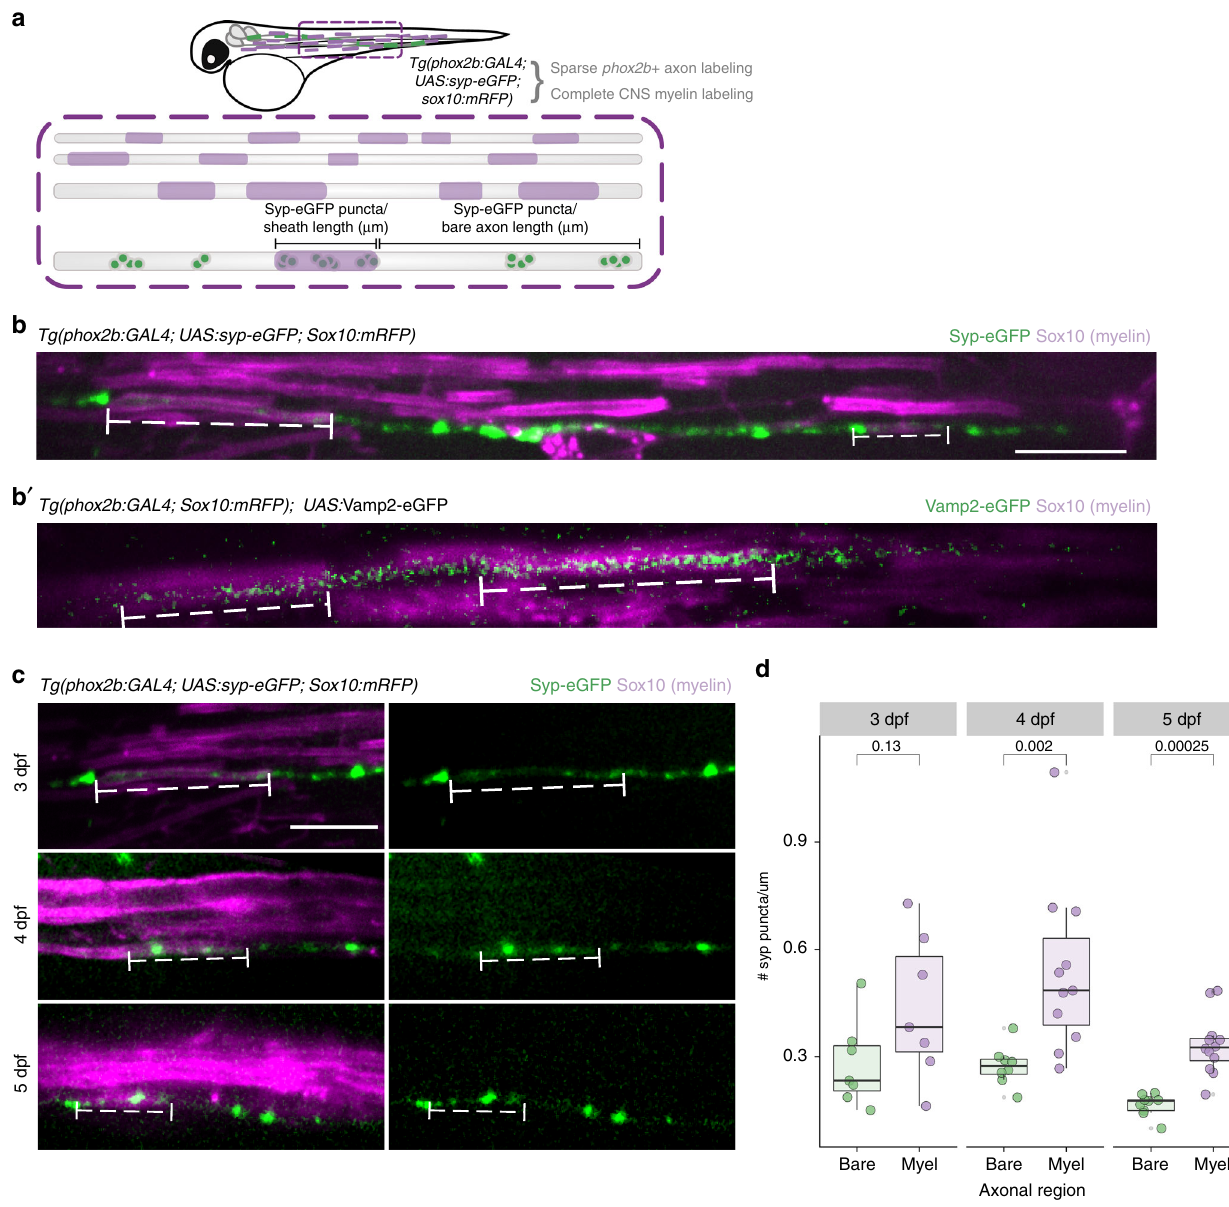
Fig. 1 Axons accumulate synaptic vesicle release machinery under myelin sheaths. a Schematic of transgenes used to assess synaptic puncta density along myelinated and bare regions of axons. b Representative image of Syp-eGFP in a myelinated phox2b + axon in a living 3 dpf Tg(phox2b:GAL4; UAS:syp-eGFP; sox10:mRFP) larva. Bracketed dashed lines indicate two myelin sheaths (rectangles) on the axon. b ′ Same as ( b ) for Vamp2-eGFP; animal genotype is Tg (phox2b:GAL4; sox10:mRFP) with transient expression of UAS:Vamp2-eGFP . c Representative images of Syp-eGFP distribution in myelinated phox2b + axons at 3, 4, and 5 dpf. d Comparisons of Syp-eGFP puncta density within bare vs myelinated regions of axons at each timepoint. n = 7 bare regions/98 puncta and 7 sheaths/18 puncta (3 dpf); 8 bare/119 puncta and 11 sheaths/43 puncta (4 dpf); 9 bare/75 puncta, and 12 sheaths/38 puncta (5 dpf). Wilcox